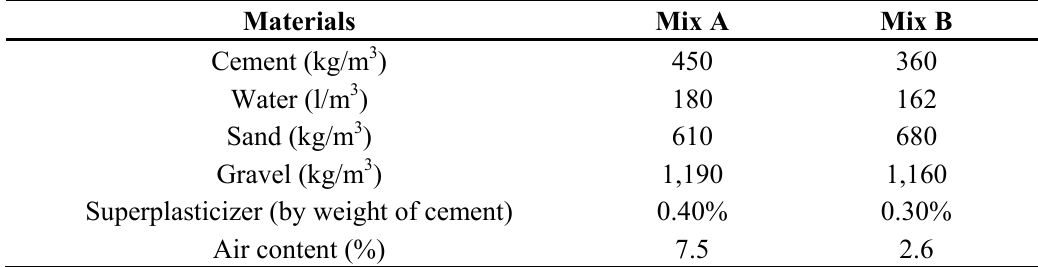
Table 2. Mix proportions and characteristics of the concrete